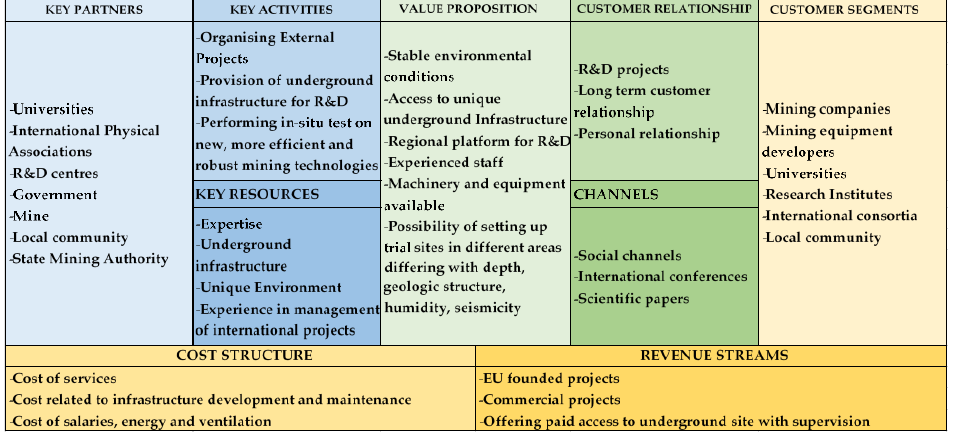
Figure 4. The general structure of the canvas business model worksheet for facility set up for development of new mining technologies.